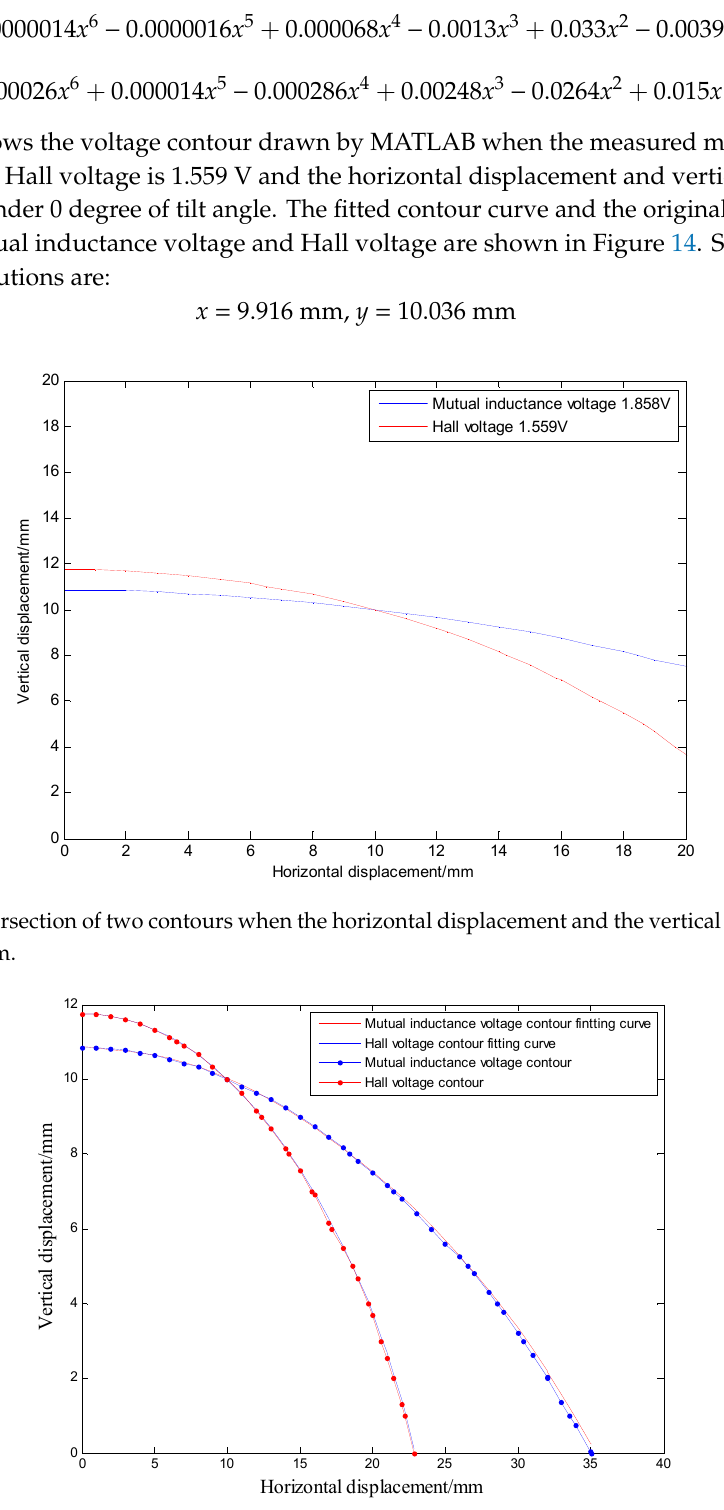
Figure 14. Contour comparison before and after fitting.